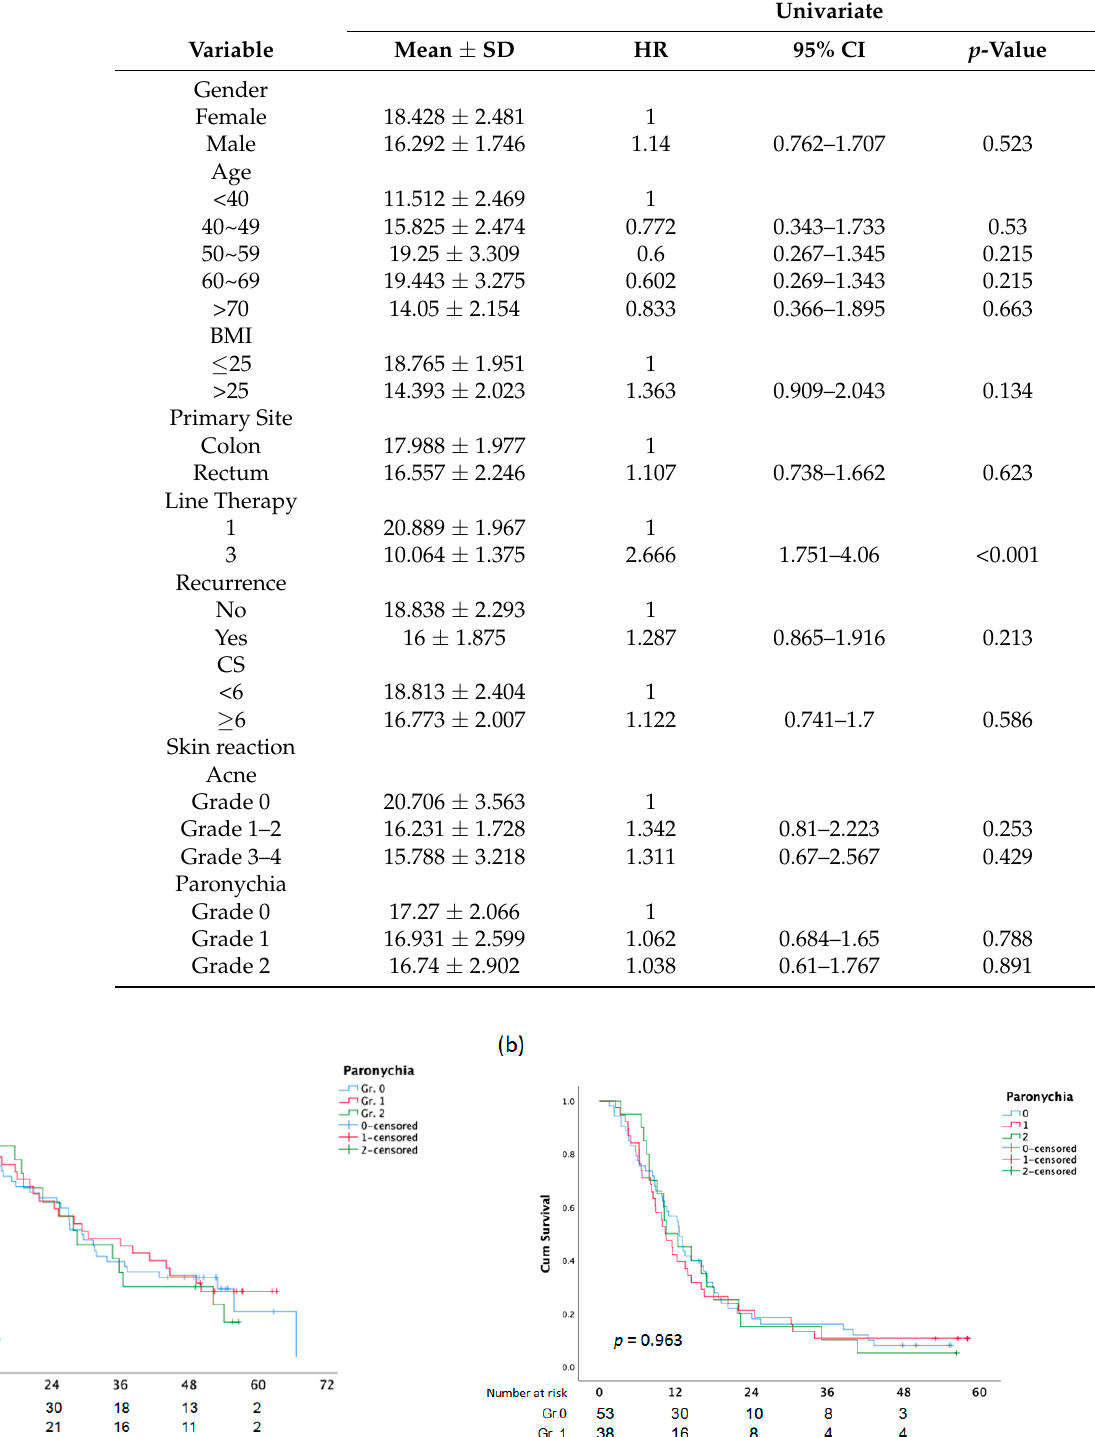
Table 5. Association of clinical variables and skin reactions with median Progression Free Survival by univariate analysis (N = 111).